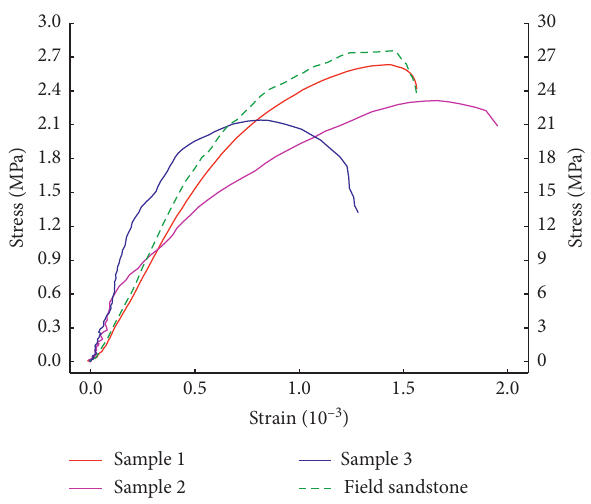
Figure 3: Stress-strain curve of uniaxial